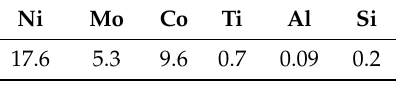
Table 1. Chemical composition (weight fraction, %) of the investigated 18-Ni 300 steel powder.